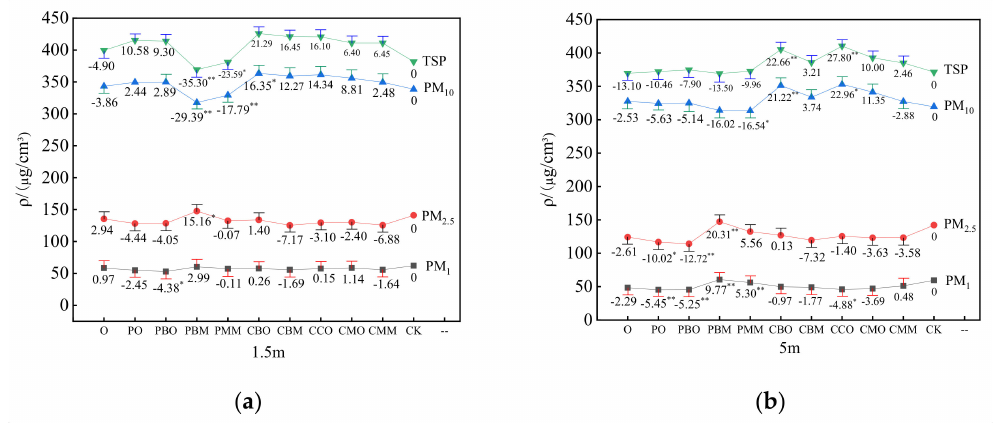
Figure 8. Comparison of airborne particulate matter concentrations in vegetation structures at differ- ent vertical heights. Note: The values in the figure represent the correlation coefficients of generalized linear analysis between green spaces with different vegetation structures and concentrations of airborne particulate matter with different particle sizes—that is, the distance between different factor levels and the population mean. **: At level 0.01 (two-tailed), the correlation was significant; *: At level 0.05 (two-tailed), the correlation was significant. ( a ) Comparison of airborne particulate matter concentrations in the different vegetation structures at 1.5m height; ( b ) Comparison of airborne particulate matter concentrations in the different vegetation structures at 5m